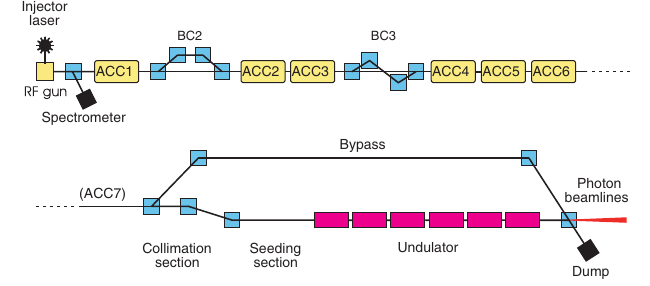
FIG. 1. (Color) Schematic layout of FLASH (not to scale). Total length is about 250 m. The elements shown include acceleration structures (yellow), FEL undulators (magenta), and main dipole magnets